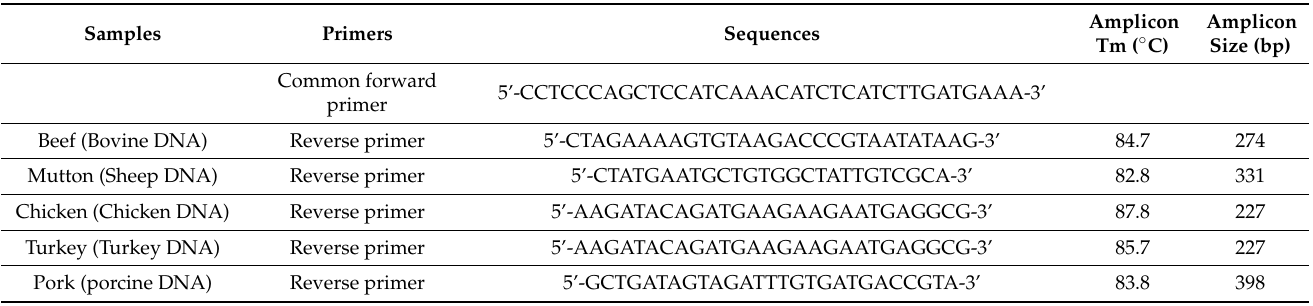
Table 3. Primer sequences designed specifically for cytochrome b gene of different meat